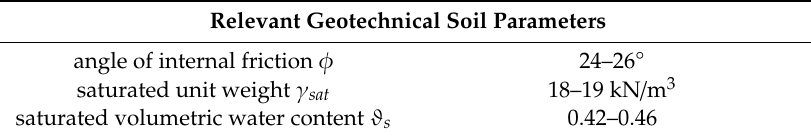
Table 1. Summary of the values assigned to relevant geotechnical parameters.